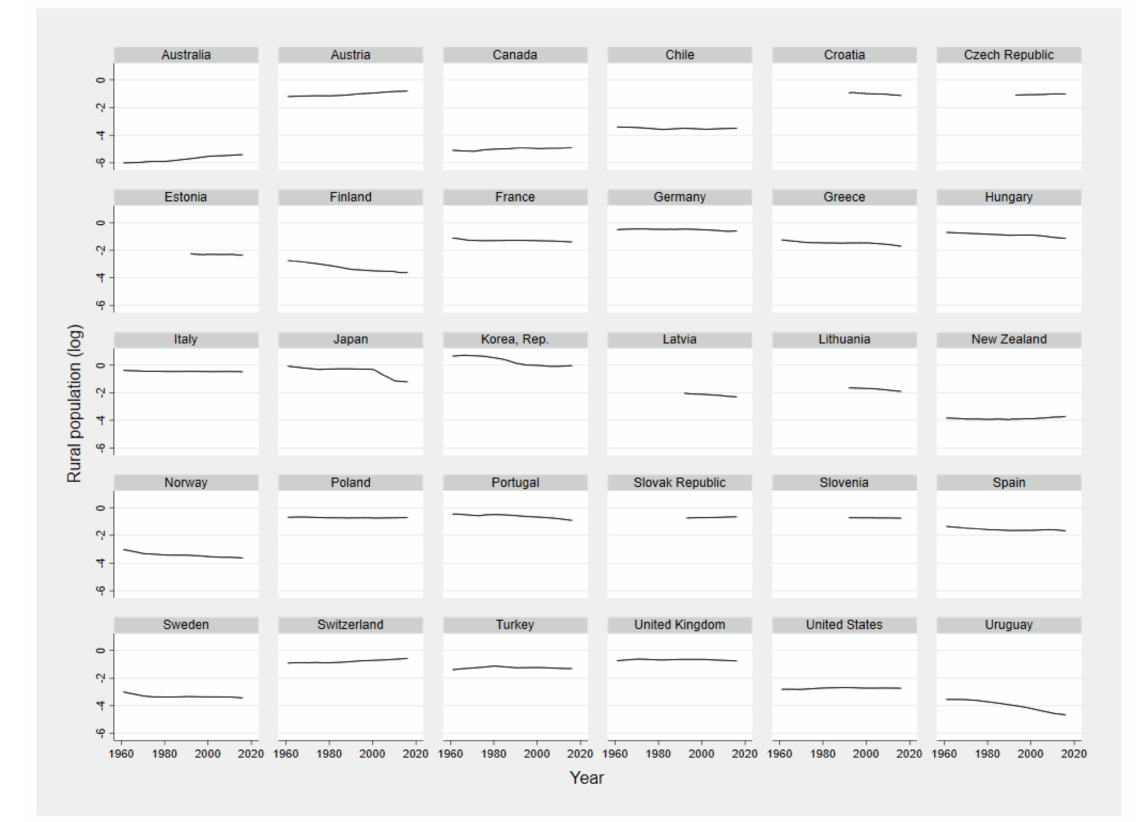
Figure A12. Temporal evolution of rural population density, high-income